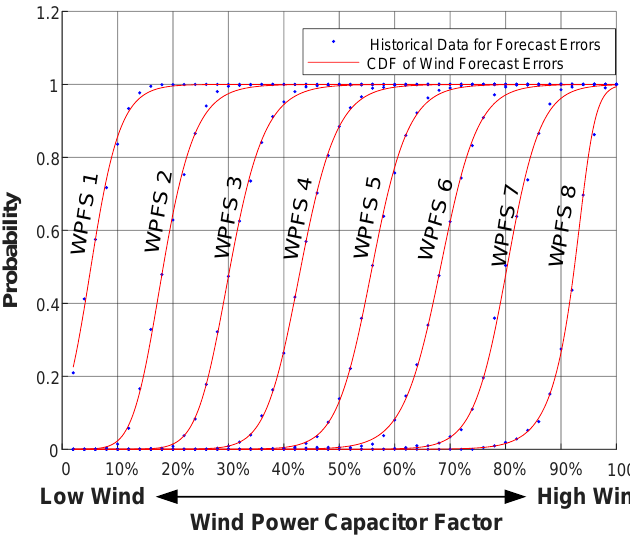
Figure 8. The CDFs for different wind power levels, i.e., Wind Power Forecast Spans.